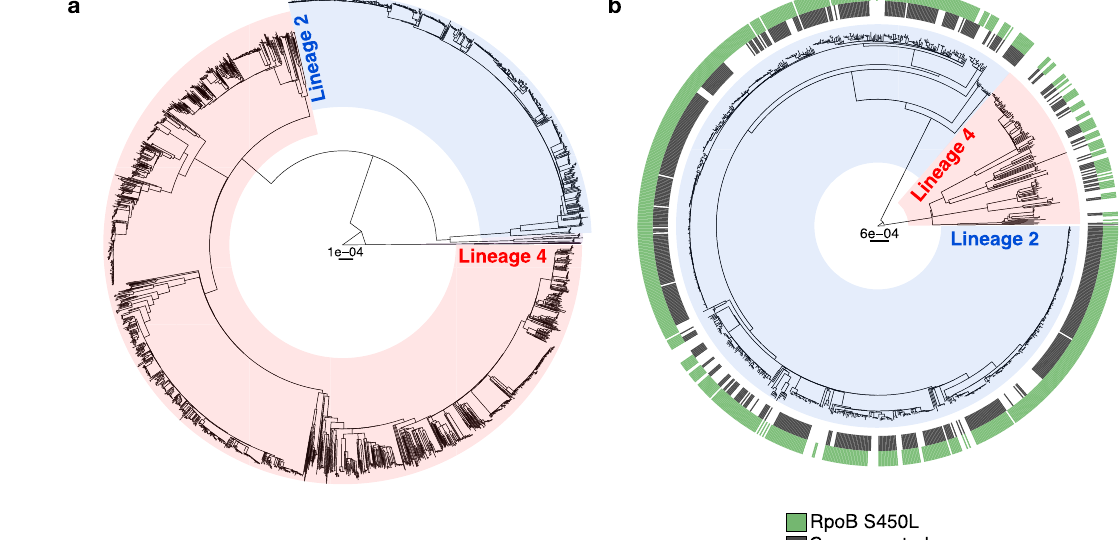
genomesthat carrytheRpoBS450Lmutation and the greyouter ringcorresponds to the presence of a compensatory mutation in rpoA/B/C . The phylogeny of drug- susceptible strains was constructed from 63,111 variable nucleotide positions and the phylogeny of MDR strains was constructed from 13,649 variable nucleotide positions. Scale bars indicate substitutions per